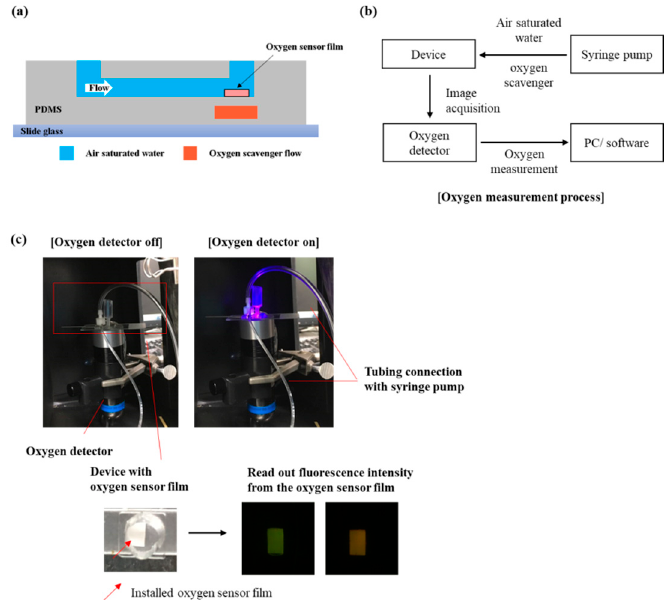
Figure 4. Oxygen level monitoring in the microfluidic device. ( a ) Schematic image of oxygen sensor film integrated device; ( b ) experimental setup for oxygen monitoring in the microfluidic device; ( c ) Experimental setup for measuring oxygen level with oxygen sensor film integrated microfluidic device.